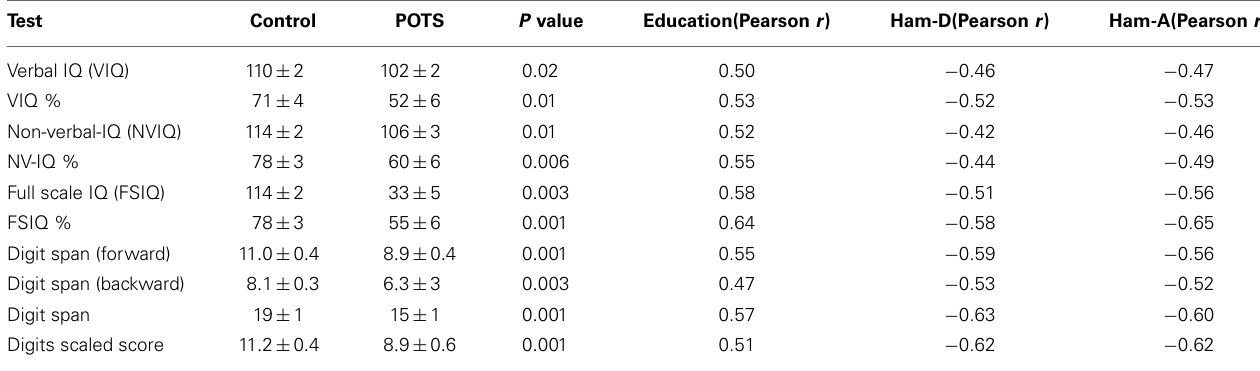
Table 3 | Cognitive profile in healthy subjects and in patients with POTS.